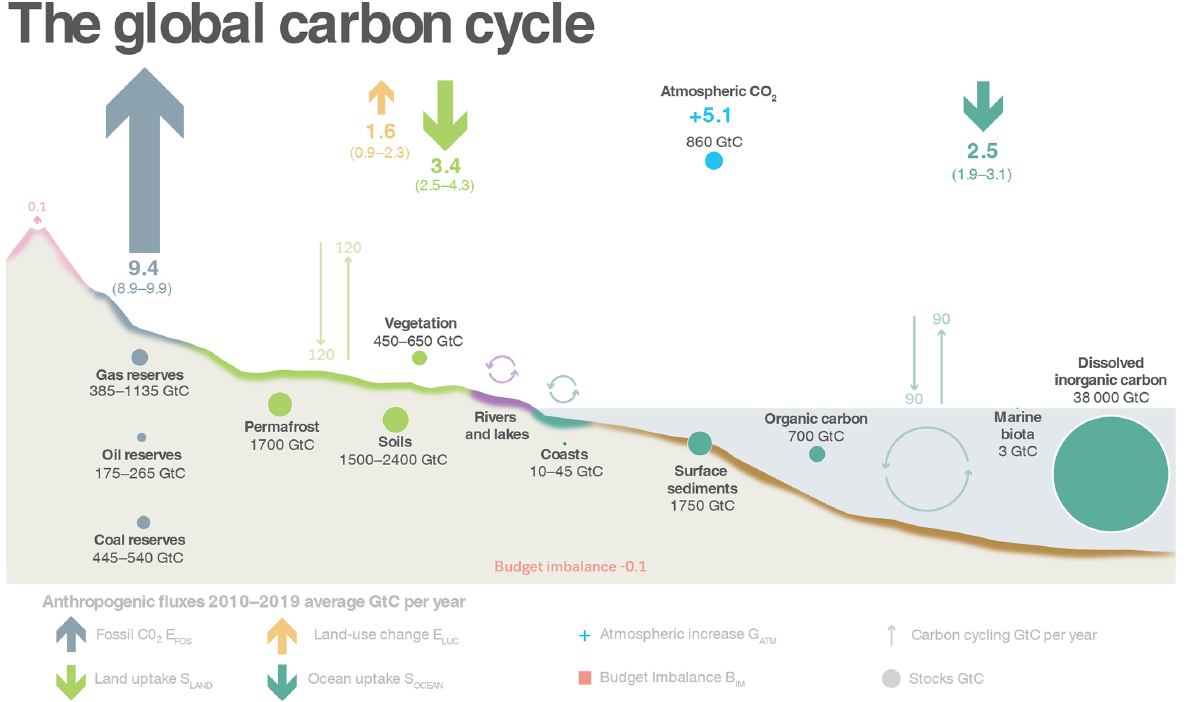
Figure 2. Schematic representation of the overall perturbation of the global carbon cycle caused by anthropogenic activities, averaged globally for the decade 2010–2019. See legends for the corresponding arrows and units. The uncertainty in the atmospheric CO 2 growth rate is very small ( ± 0.02GtCyr − 1 ) and is neglected for the figure. The anthropogenic perturbation occurs on top of an active carbon cycle, with fluxes and stocks represented in the background and taken from Ciais et al. (2013) for all numbers, with the ocean gross fluxes updated to 90GtCyr − 1 to account for the increase in atmospheric CO 2 since publication, and except for the carbon stocks in coasts which is from a literature review of coastal marine sediments (Price and Warren, 2016). Cement carbonation sink of 0.2GtCyr − 1 is included in E FOS .